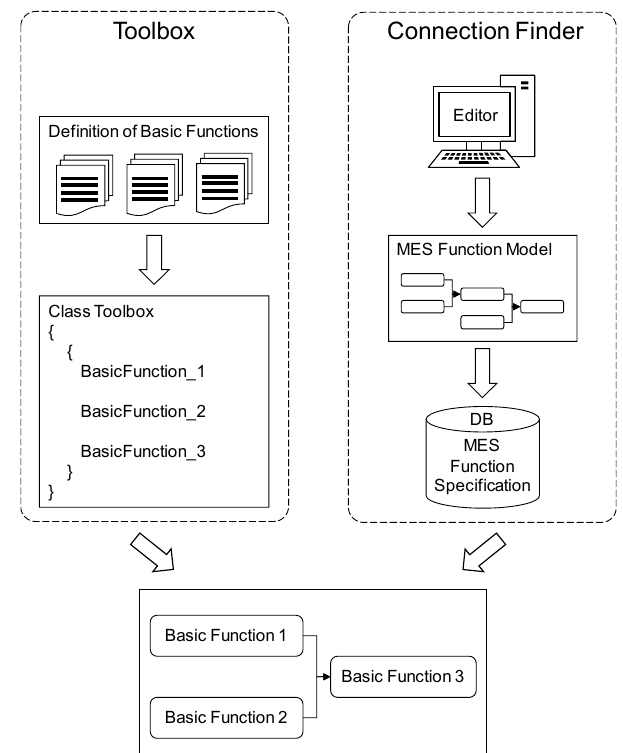
Figure 8. The back-end of the generator for data processing.